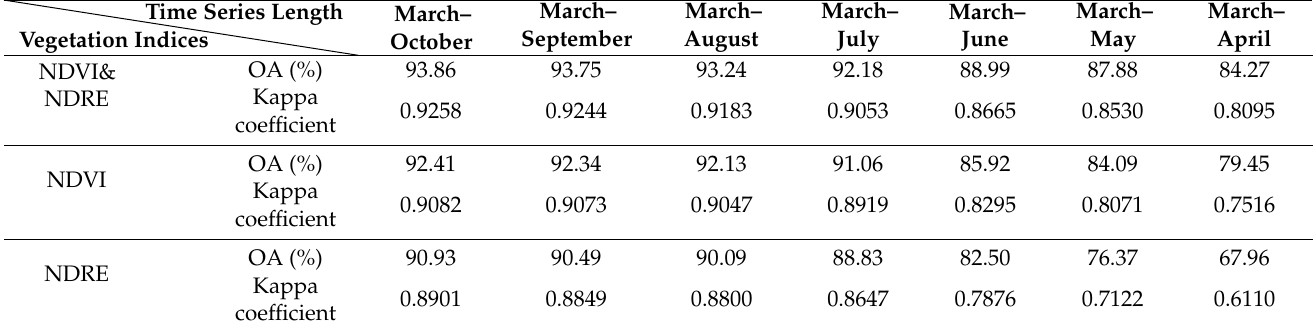
Table A1. OAs and kappa coefficients of NDVI&NDRE, NDVI, and NDRE time series about different length in 2019.